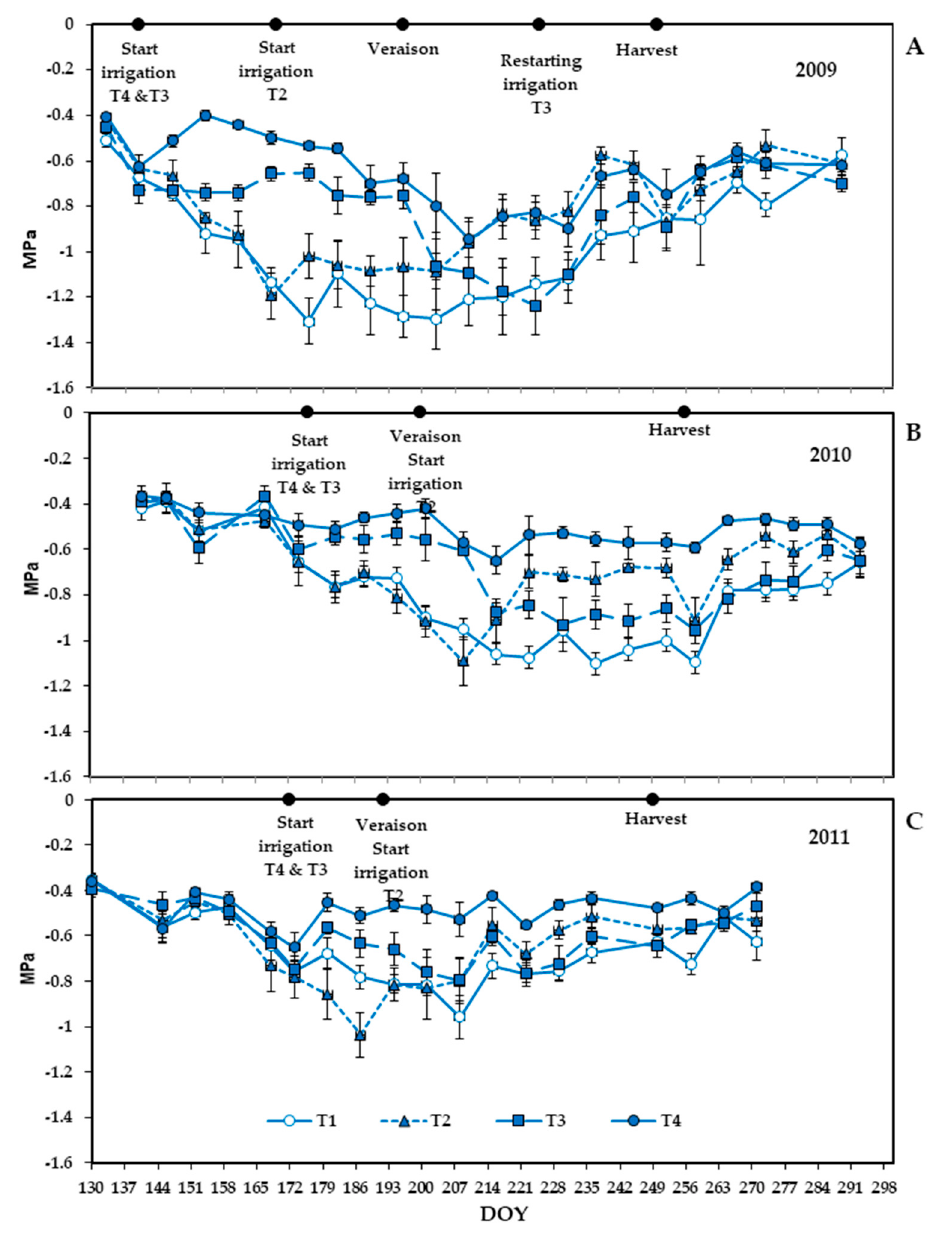
Figure 1. Seasonal evolution of stem water potential measured at midday ( ψ smd ) in the four irrigation treatments in years ( A ) 2009, ( B ) 2010, and ( C ) 2011. Each point is the average of the four elementary high load plots. The bars represent the standard error of the average.